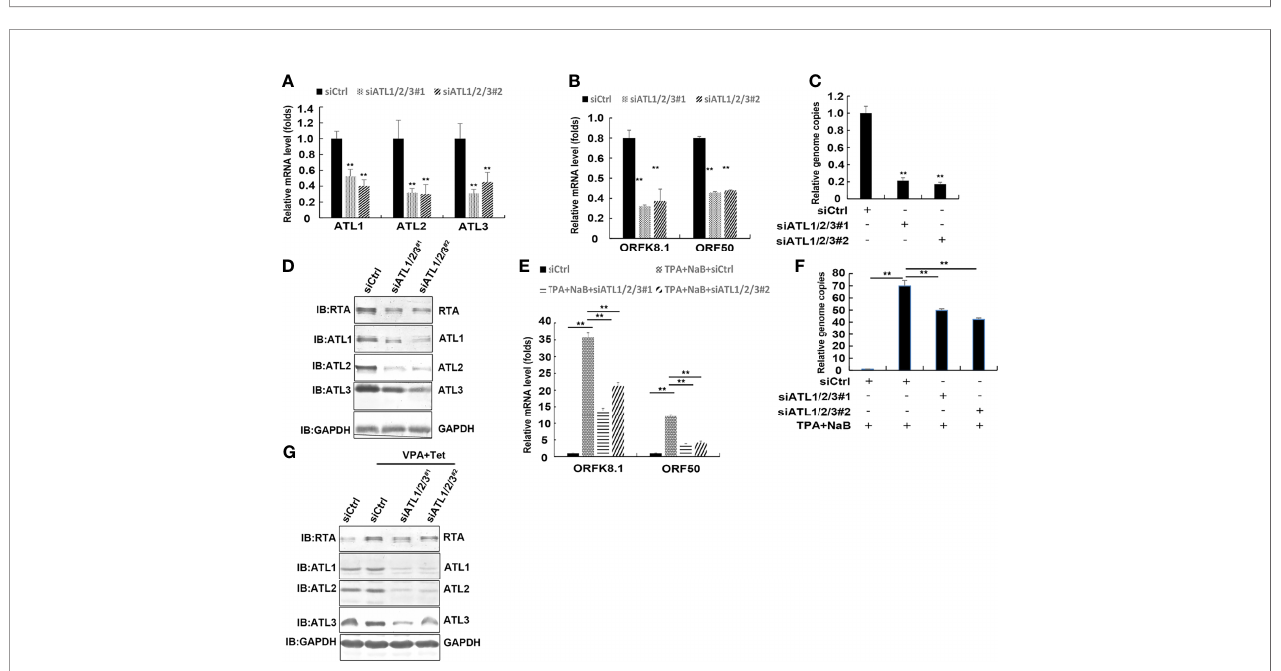
FIGURE 6 | Silencing of ATLsimpairs spontaneous and TPA induced KSHVlytic activation andvirus particleproduction in BCBL-1 cells. BCBL-1 cells were transfected with siCtrl, siATL1/2/3#1 orsiATL1/2/3#2 respectively. After 48 hours, knockdownef fi ciencies of siATL1/2/3in BCBL-1 cellsweremeasured byRT-qPCR (A) . mRNA levels of KSHVlytic genes ORFK8.1 and ORF50 were measured by RT-qPCR, with normalization to actin using the DD CT method (B) . Viral DNA in the mediawas quanti fi ed using qPCR,with normalization to an addedplasmid FAM105B using the DD CT method (C) . BCBL-1 cells were transfected with siCtrl, siATL1/2/3#1 or siATL1/2/3#2 respectively followedby treatment with TPA plusNaB for 48 hours to induce KSHV lyticreactivation. (D) Proteins were detected bywesternblotwith indicated antibodies. (E) mRNA levelsofKSHV lyticgenes ORFK8.1 and ORF50 weremeasured byRT-qPCR,with normalization to actin usingthe DD CT method. (F) Viral DNA in the media was quanti fi ed usingqPCR, with normalization to an added plasmid FAM105B using the DD CT method.Data arepresentedas means of three technical replicates (n=3, group values are indicatedby mean ± SEM;**p<0.01). (G) Proteins were detected bywestern blot with